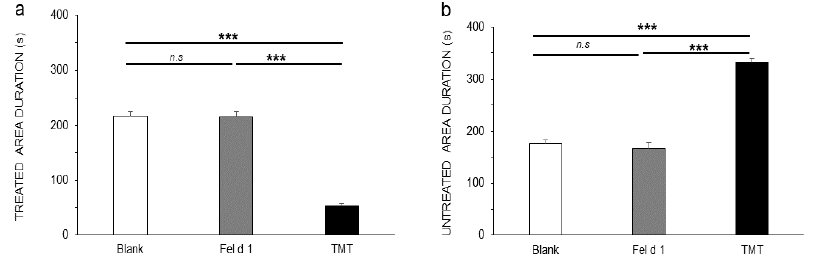
Figure 2. Durations in the treated vs. untreated areas for each treatment showing sex-by-area interactions ( a – c ). GLM procedure was used to evaluate the effects of the sex-area interactions, followed by a Tukey test and LSmeans comparisons. The results are shown as the mean ± SE. The significance threshold is fixed at 5%. n.s, non-significant. p < 0.05 *.